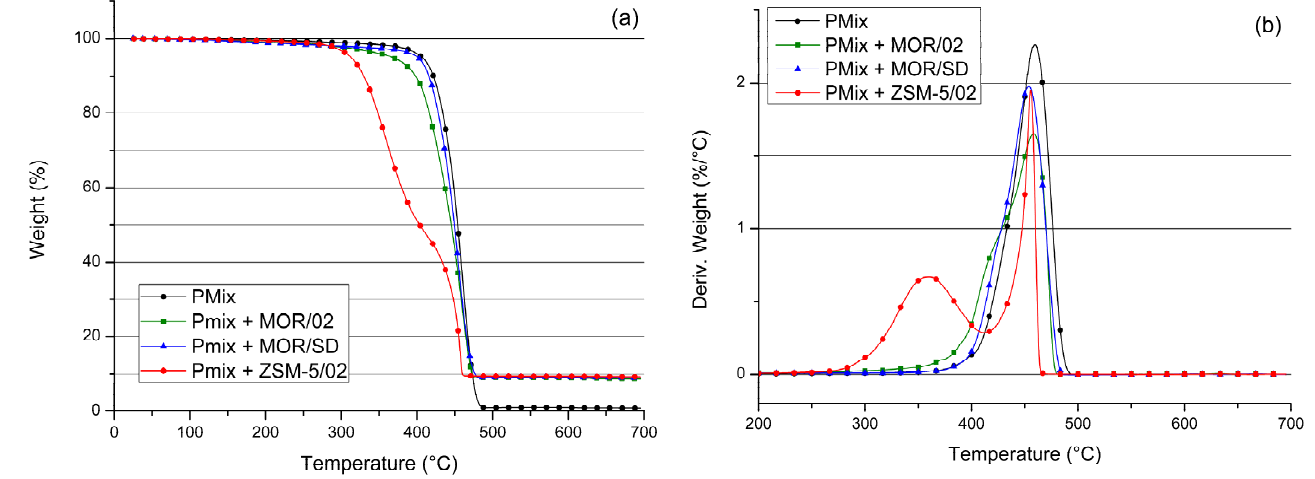
Figure 5. TG ( a ) and DTG ( b ) curves for PMix with catalysts.